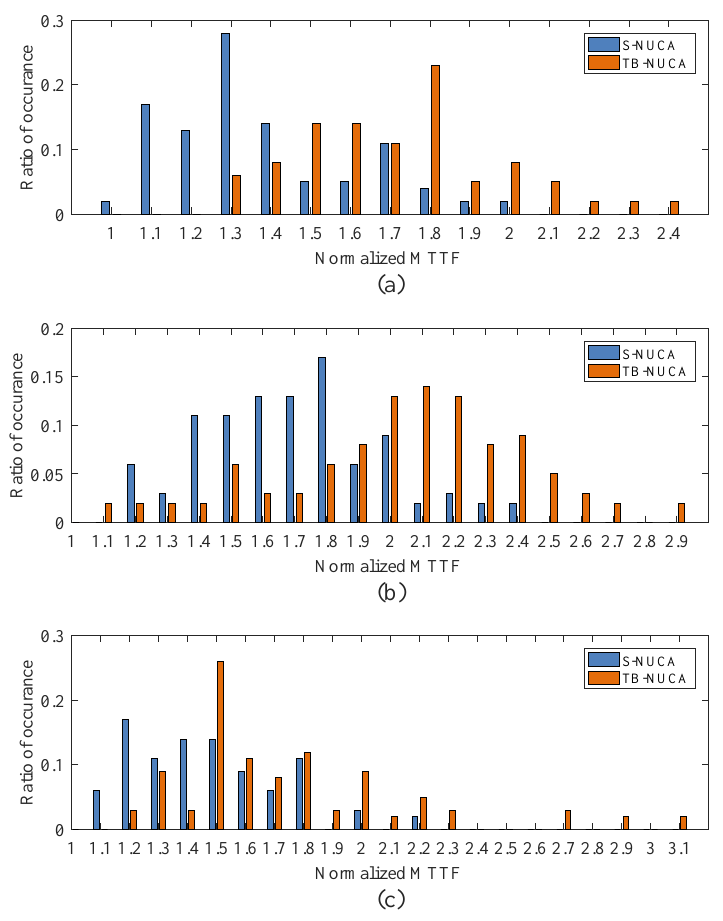
Figure 7. Effect of mapping scheme on MTTF distribution under different synthetic traffic patterns. ( a ) Random, ( b ) Transpose-2. ( c ) Shuffle.